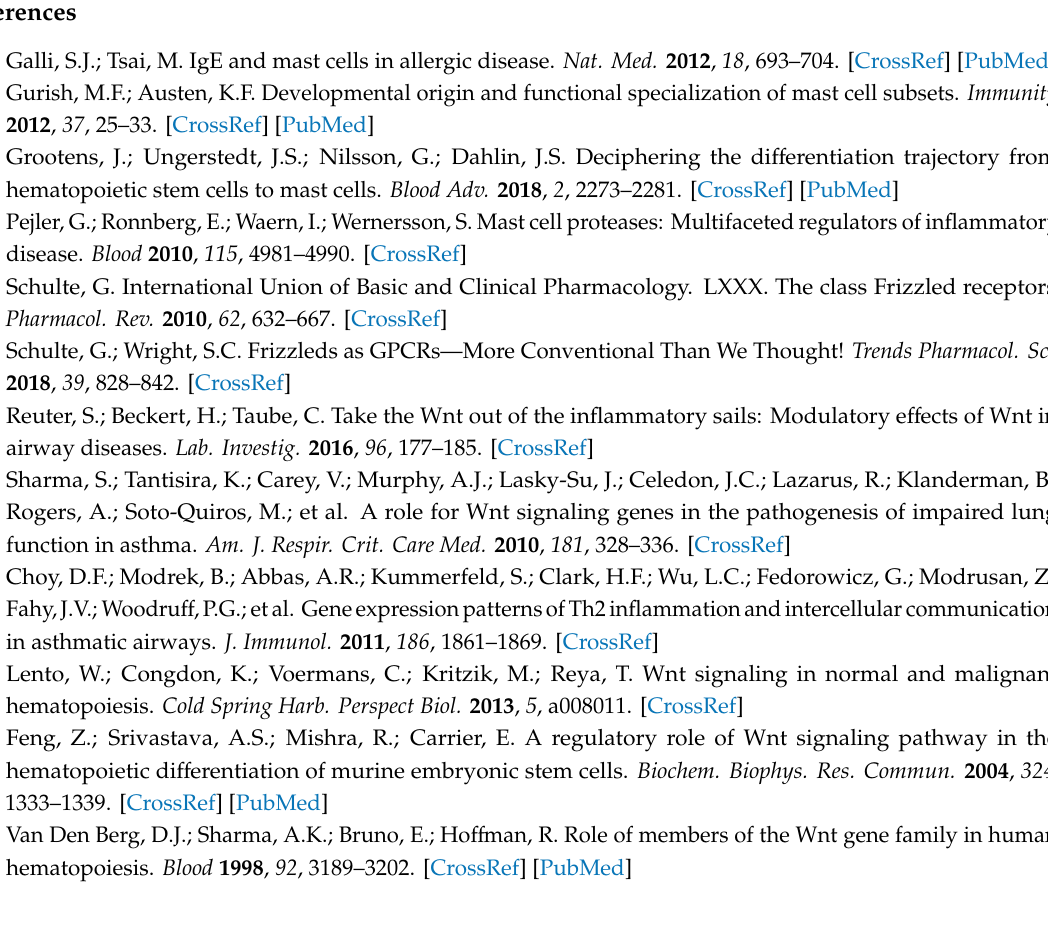
Figure S1A: Expression of FZDs in human lung mast cells; Figure S1B: Expression co-receptors in human lung mast cells; Figure S1C: Expression of Wnts inn human lung mast cells; Figure S1D: Expression of Wnts in human lung tissue; Figure S1E: Expression of FZDs in human skin mast cells; Figure S2: Olink screen of released